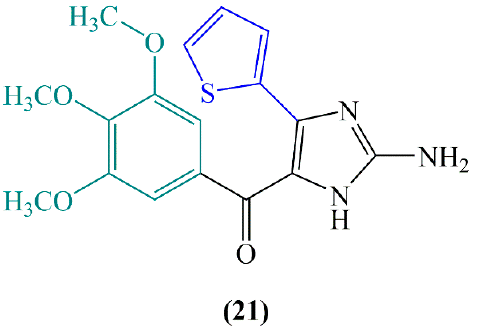
Figure 10. Structure of combretastatin inspired 2-aminoimidazole (21).